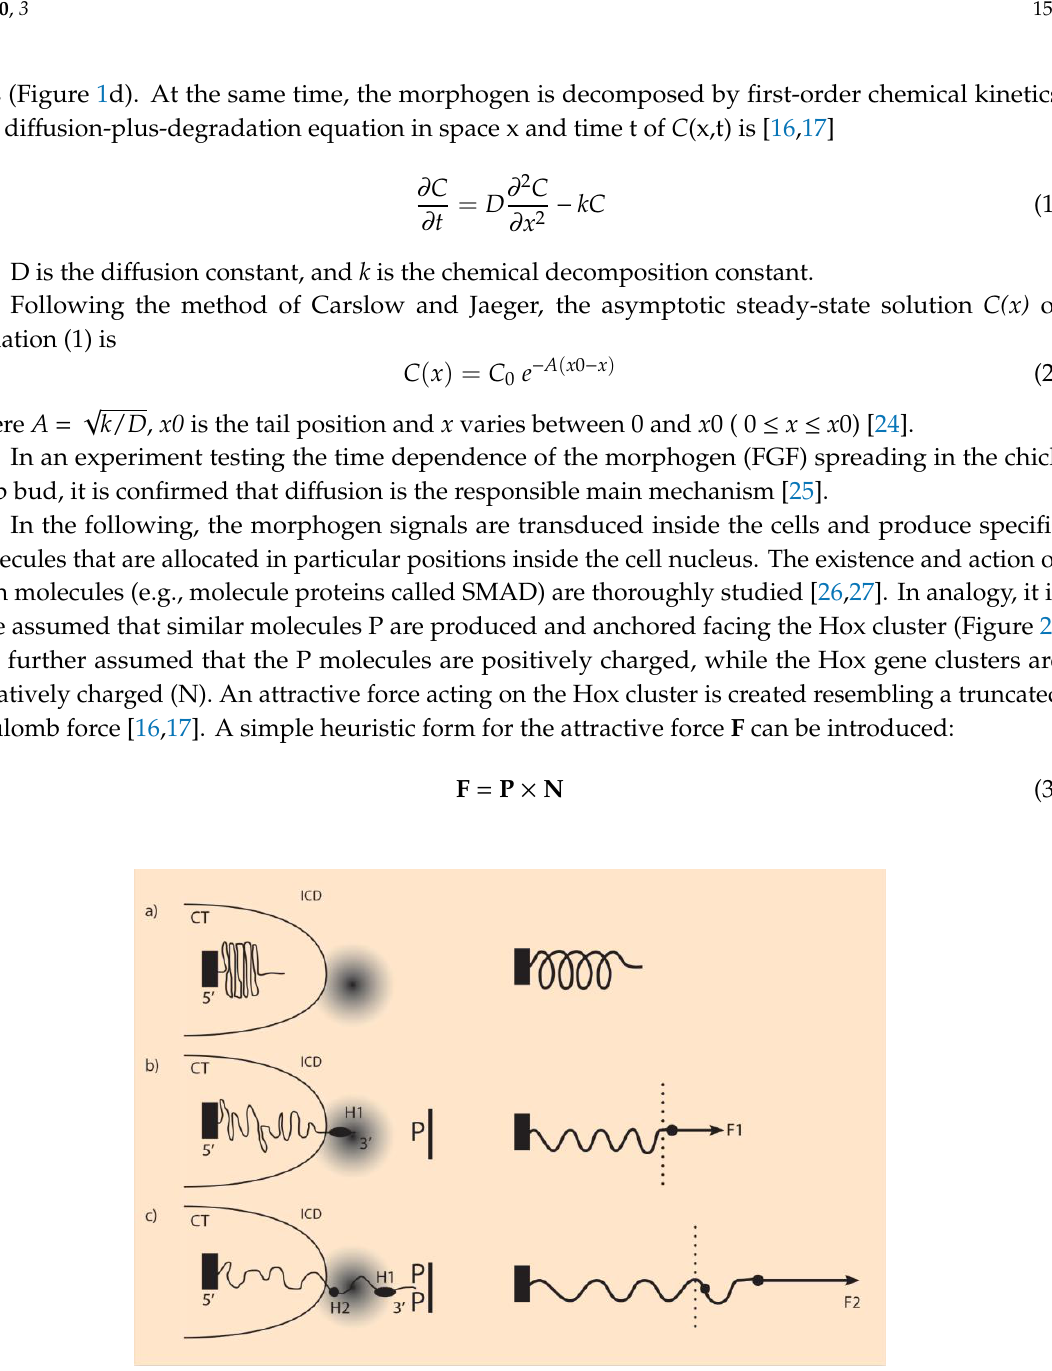
Figure 2. Hox cluster elongation and its mechanical analog (adapted from [17]). ( a ) (Left) Before activation, the Hox cluster is condensed inside the chromatin territory (CT).The transcription factory region outside CT is shadowed. (Right) Mechanical analog of an uncharged elastic spring fastened at its left end. ( b ) (Left) The fixed pole P pulls Hox1 (H1) outside the cluster in the intra chromosomal domain (ICD) towards the transcription factory. (Right) A small force F1 expands the spring. ( c ) (Left) The attracting force of pole P increases (PP), and besides Hox1, Hox2 is also extruded. (Right) The attracting force F2 is stronger than F1, and the spring is further elongated.